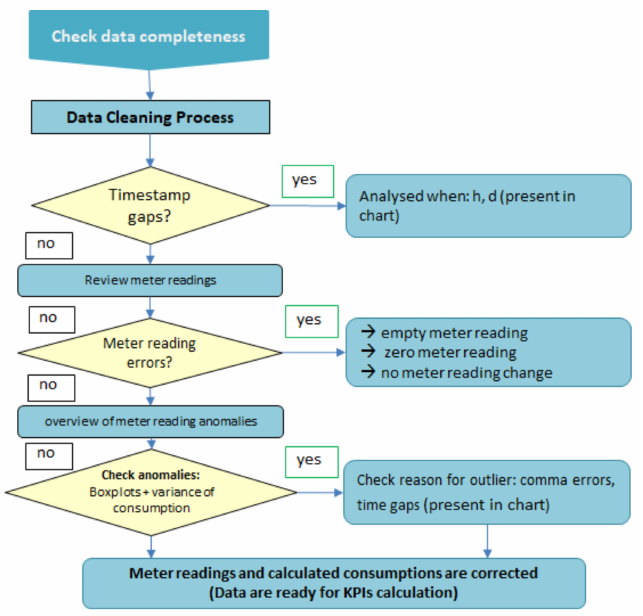
Figure 8. Main steps of the cleaning process for the measured raw